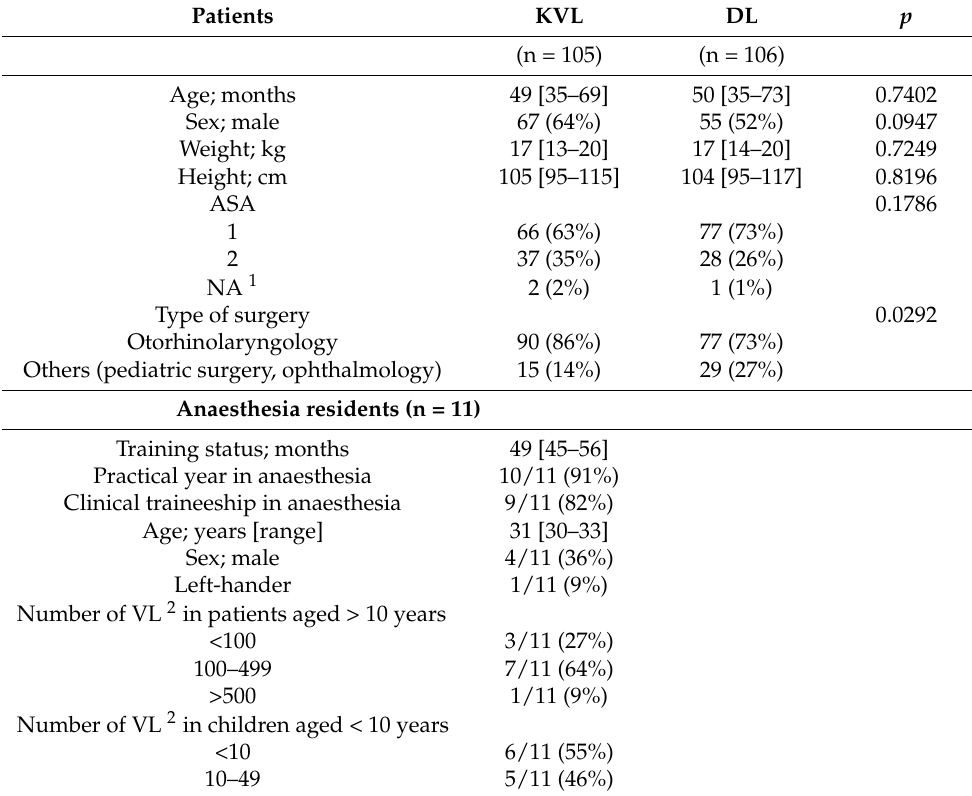
Table 1. Patient and anaesthesia resident characteristics in the King Vision™ Paediatric aBlade™ video laryngoscope (KVL) and conventional direct laryngoscopy (DL) group. Values are numbers (proportion) or median